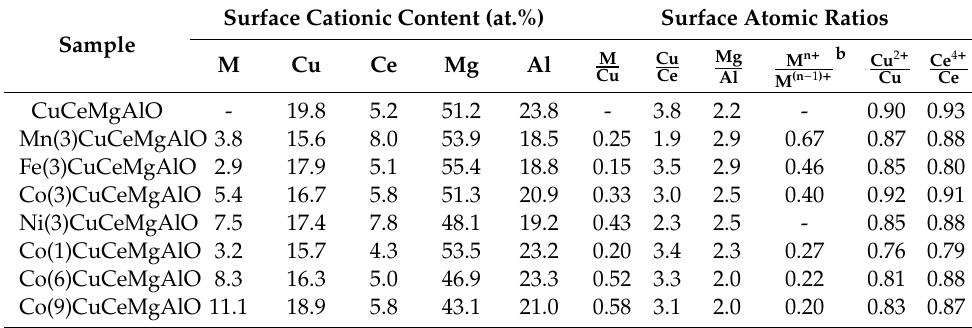
Table 4. Surface cationic composition of the mixed oxide catalysts determined by XPS analysis a.